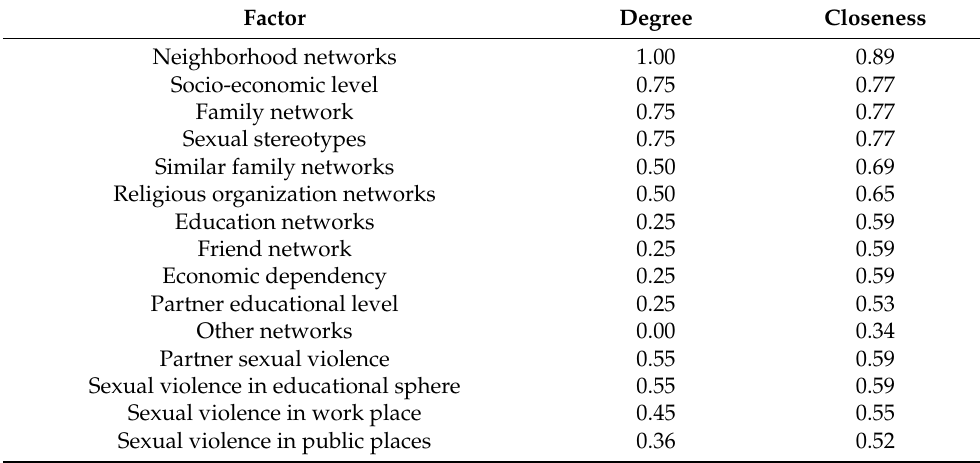
Table 5. Centrality indicators of degree and proximity of the nodes in the protection